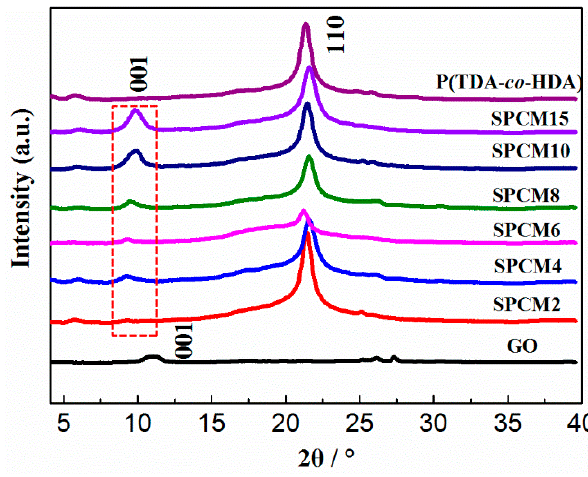
Figure 6. X-ray di ff raction (XRD) patterns of GO, P(TDA- co -HDA), and the Figure 6. X-ray diffraction (XRD) patterns of GO, P(TDA- co -HDA), and the SPCMs.